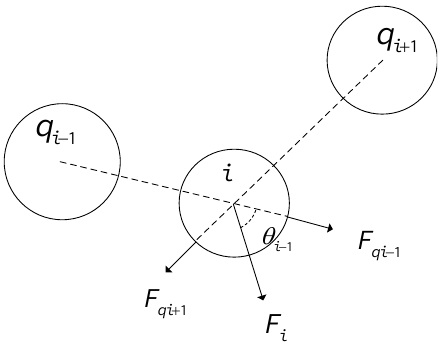
Figure 3. Schematic diagram of potential field force.